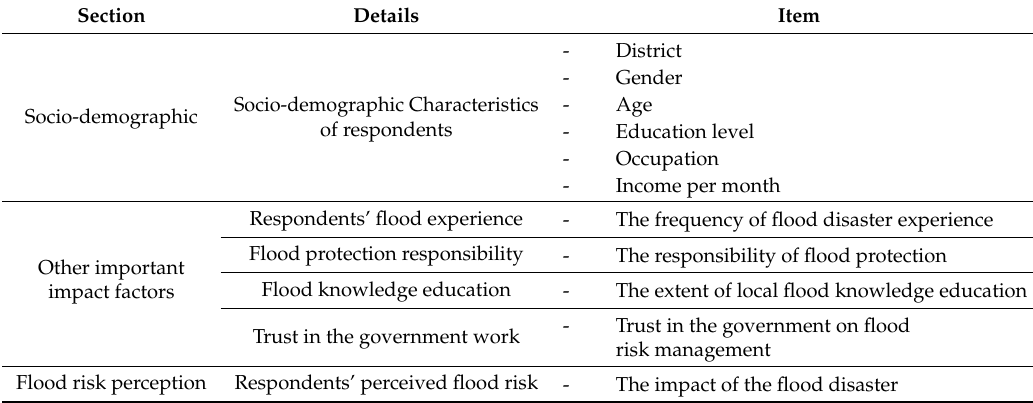
Table 1. Definition of measurement and impact factors of public flood risk